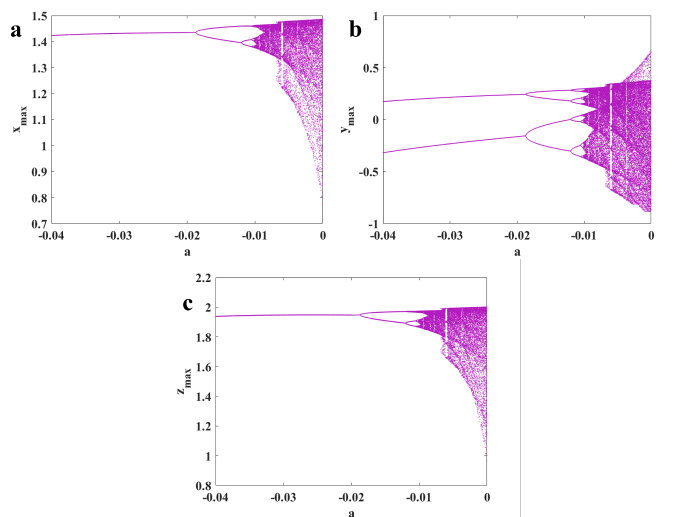
Figure 5. Bifurcation diagram of Equation (1) by changing parameter a and backward continuation